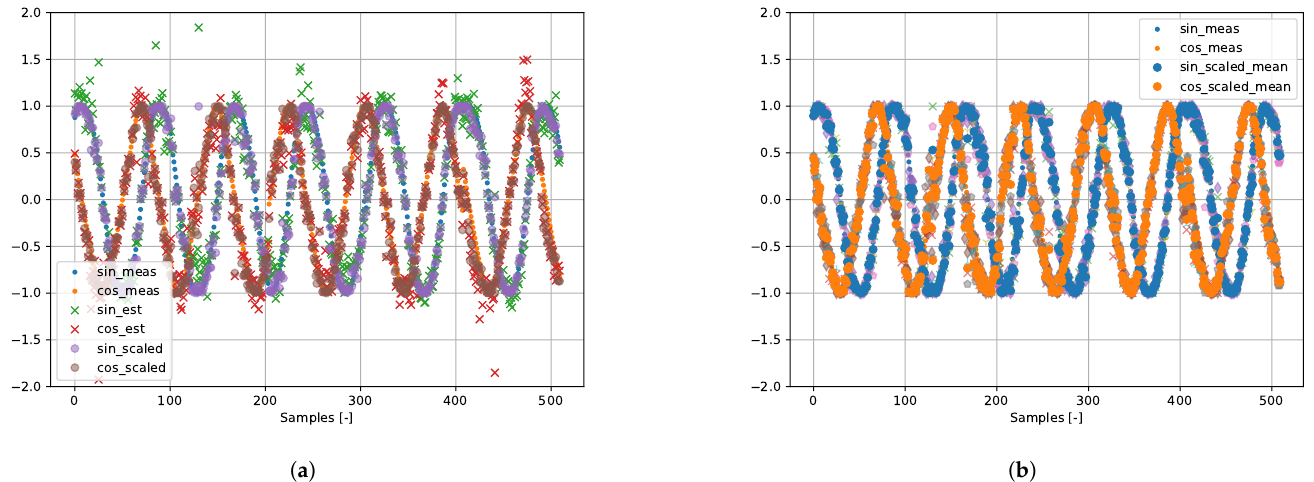
Figure 11. Multiple shaft rotations (electric angle), sine, and cosine of shaft position. ( a ) Using a single ANN. ( b ) Using multiple ANNs. It can be seen that in this case the estimated points lie closer to the corresponding measured values.